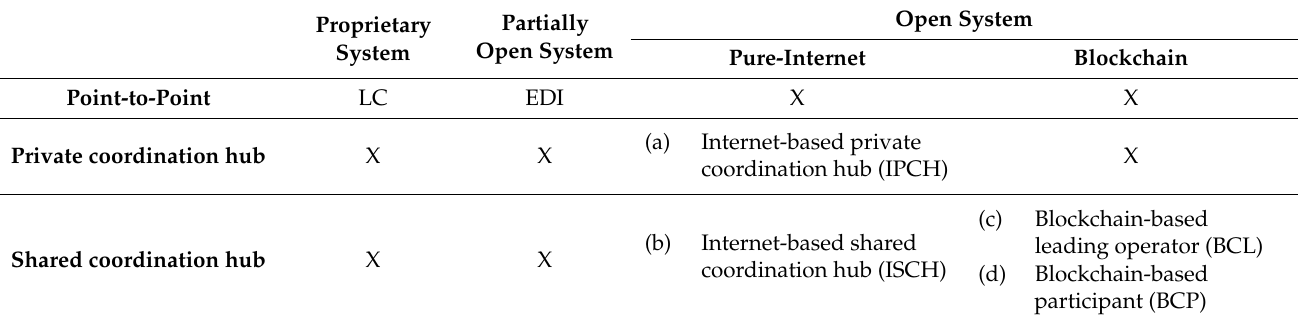
Table 1. SCF system categorization and four Fintech